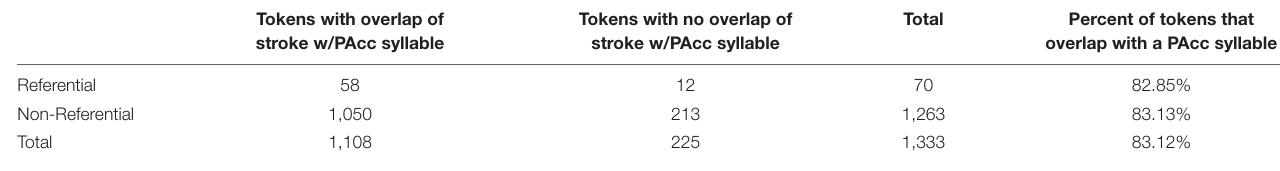
TABLE 1 | The proportion of SDGs whose strokes overlap in time with a pitch-accented syllable, for gestures perceived as Referential vs. Non-Referential. Tokens with overlap of Tokens with no overlap of stroke w/PAcc syllable stroke w/PAcc